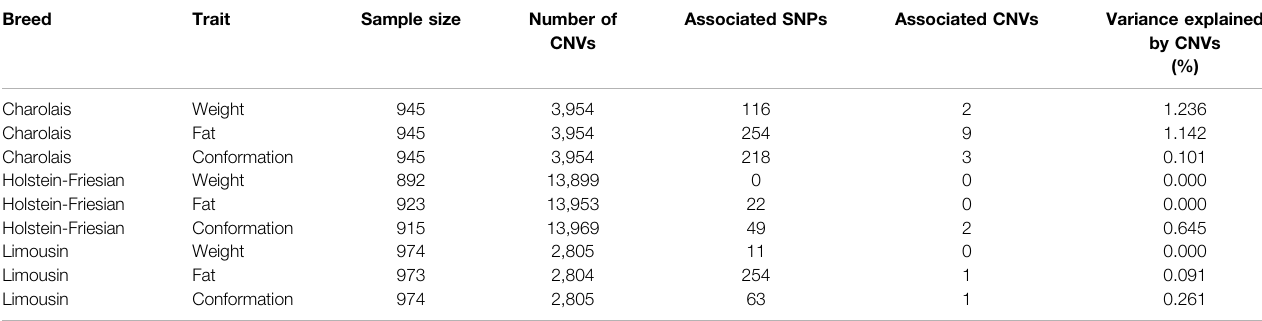
TABLE 1| Thenumber ofanimalsand copy number variants (CNVs) available for each breedand trait alongwiththenumber ofSNPs and CNVs associated witheach ofthe threecarcass traitswithinbreed,andthepercentage ofthegeneticvariance accountedforbytheassociatedCNVsidenti fi edbytheLASSOregressionanalysisforeach breed and